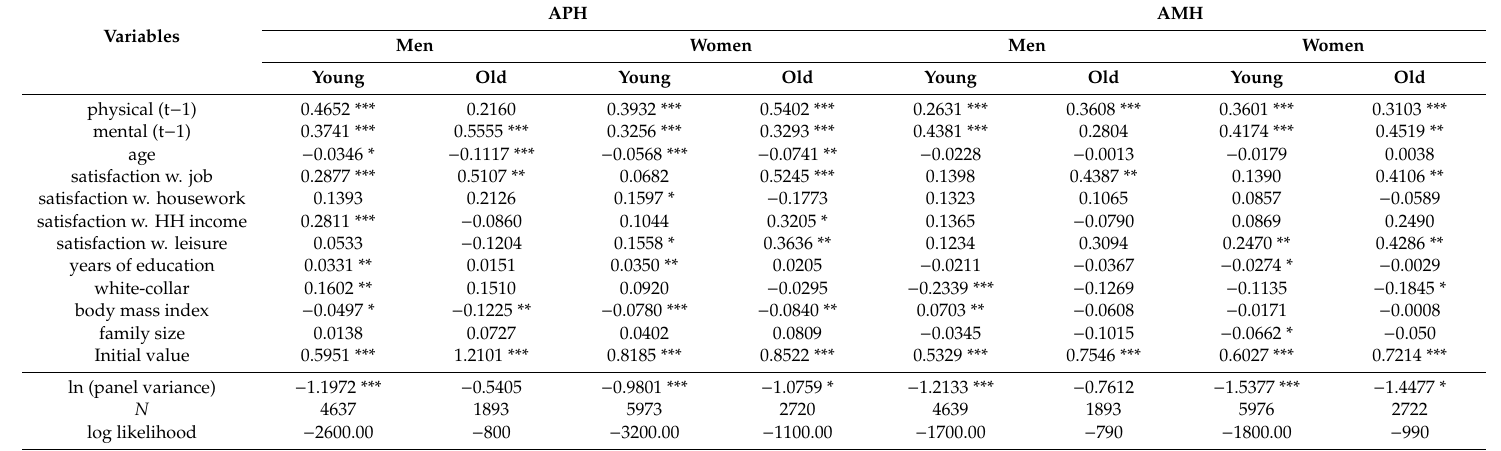
Table 8. Estimation results: coe ffi cient estimates of aggregate level in small sample.